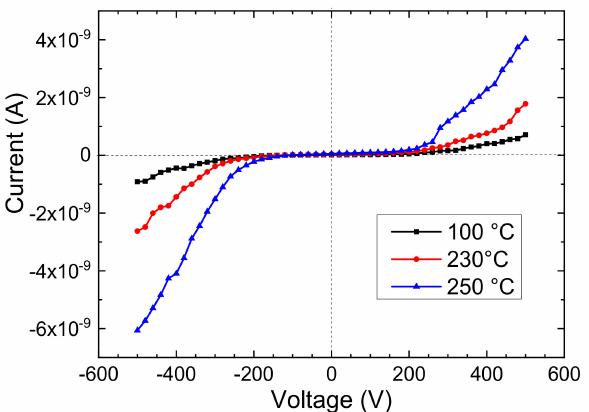
Figure 22. Measured dark current versus applied voltage for a 500 µ m thick SCD detector with Ag contacts. Let us note that (in the scale of this figure) the leakage current at room temperature practically lies on the horizontal axis (not shown